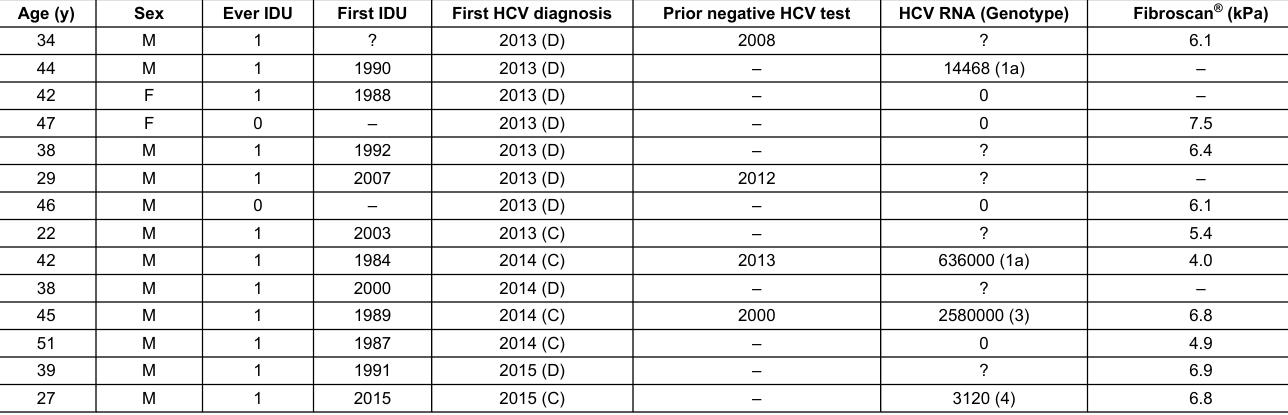
Table 3: Characteristics of the 14 new HCV diagnoses made by rapid